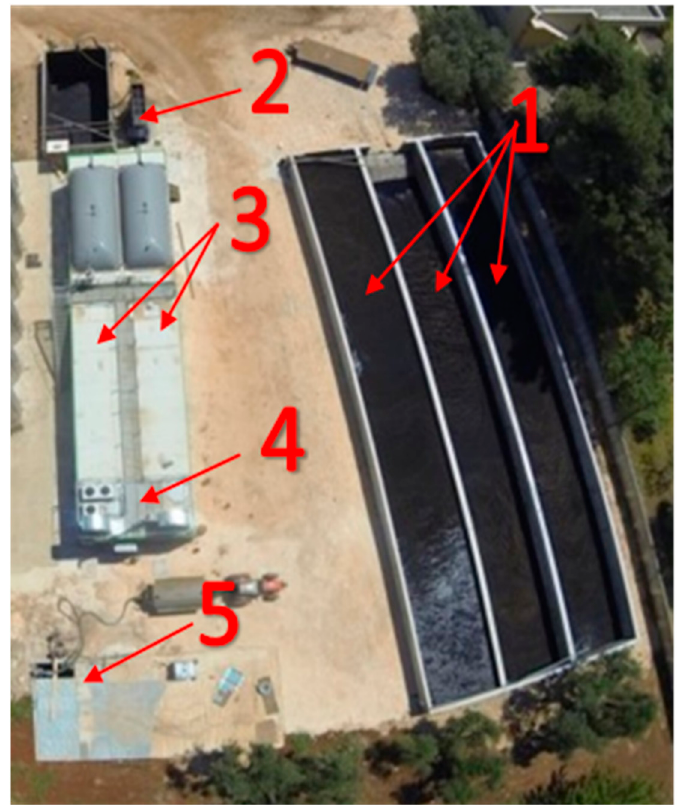
Figure 1. Overview of the full-scale anaerobic digestion plant. (1) biomass storage tanks; (2) loading hopper; (3) plug-in digesters; (4) cogenerator engine; (5) cogenerator biogas line; (f) digestate storage tank.